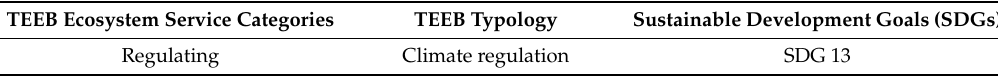
Table 1. Connections between regulating ecosystem services and selected Sustainable Development Goals (SDGs) in relation to atmospheric calcium and magnesium deposition for potential soil inorganic carbon (SIC) sequestration (adapted from Wood et al., 2017 [3]).